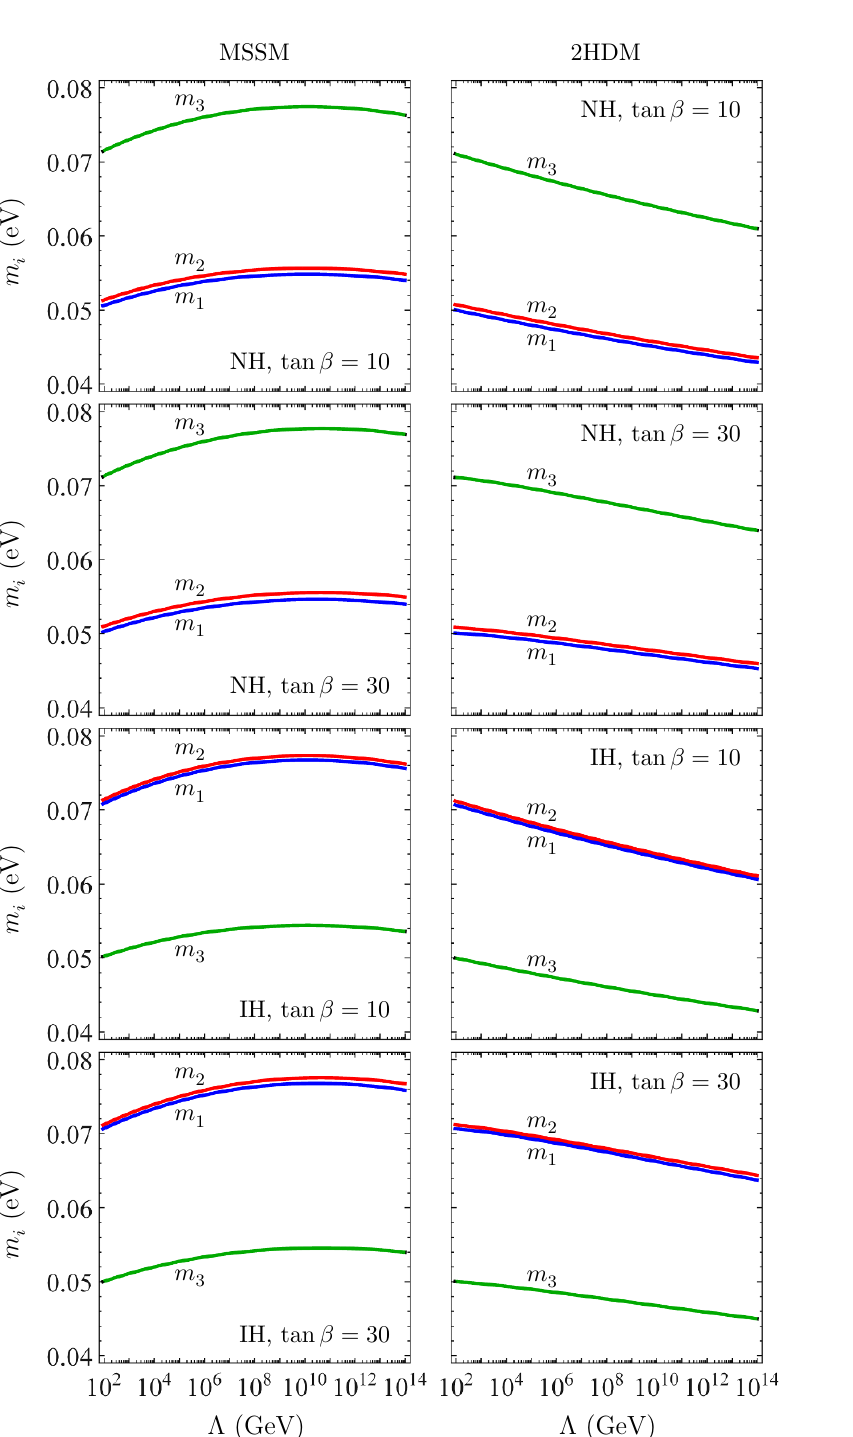
Figure 4 . The three neutrino masses evolving with the energy scale Λ in the MSSM and the type-II 2HDM, where m = 0 . 05 eV at Λ = 10 2 GeV is typically input and θ F lightest at Λ = 10 14 GeV are fixed by the µ - τ reflection µτ